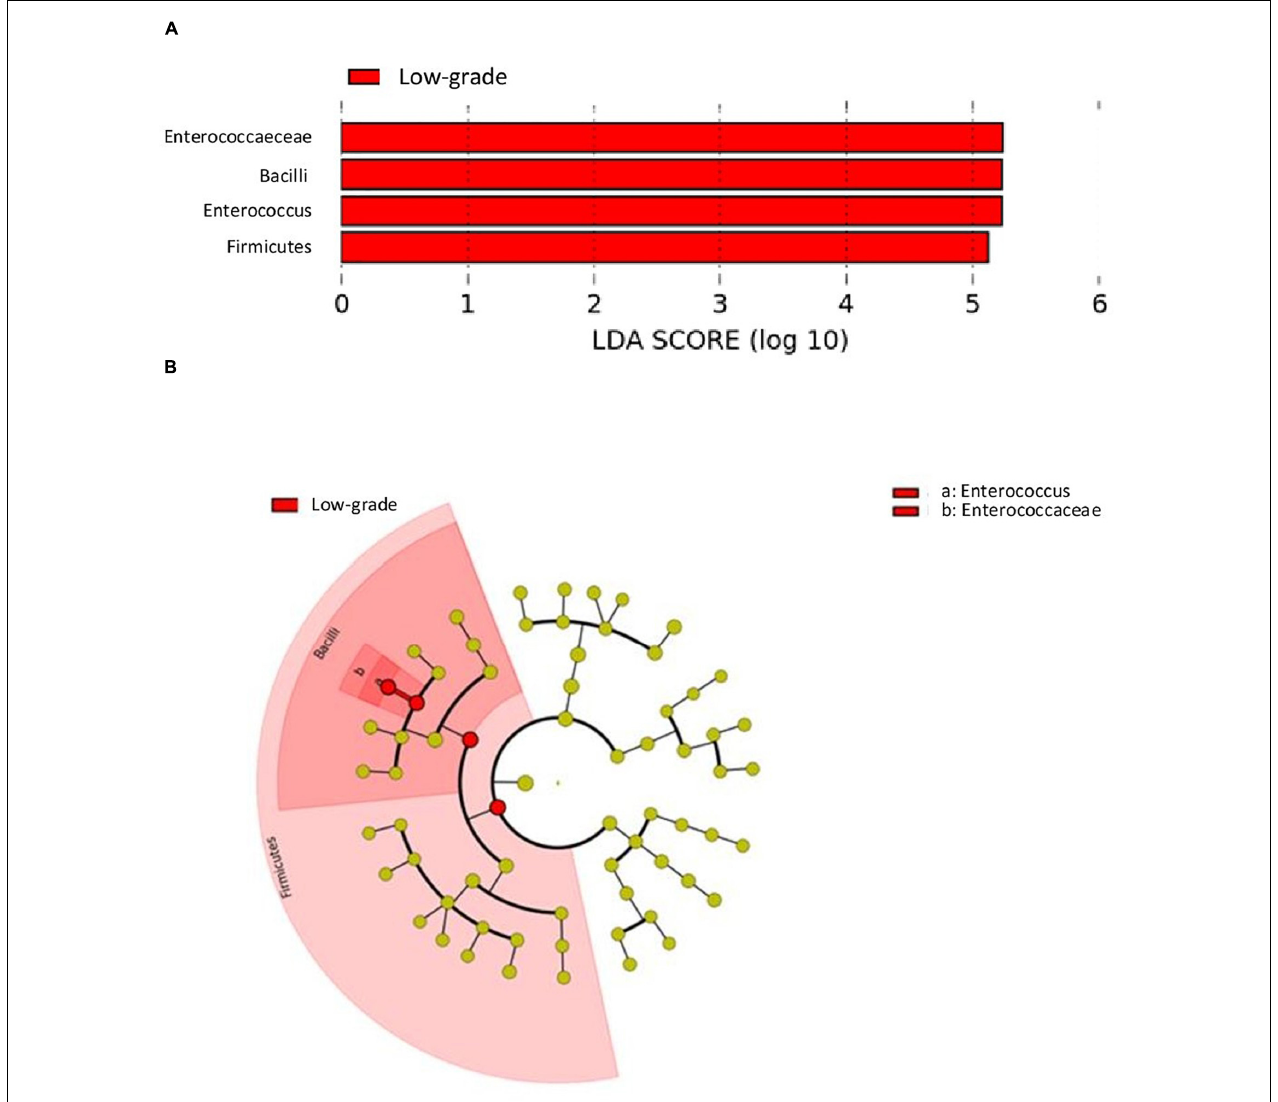
FIGURE 4 | LDA effect size (LefSe) analysis showing a greater enrichment for Enterococcus in low-grade tumors. (A) The histogram of the Linear discriminant analysis (LDA) scores illustrating the differentially abundant taxa in the low-grade tumors. Horizontal bars represent the effect size for each taxon: red color indicates taxa enriched in low-grade tumors group and green color would indicate taxa enriched in high-grade tumors group (absent because there were no differentially abundant taxa in high-grade tumors). (B) The cladogram illustrating the different taxonomic level from inside to outside that are significantly more abundant in low-grade tumors group: the genus Enterococcus (a) and the family Enterococcaceae